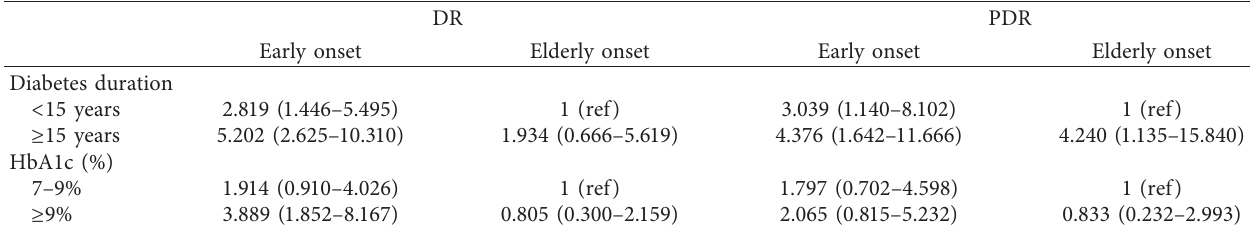
Table 2: Odds ratios of DR and PDR by onset age of T2D and category of diabetic duration or